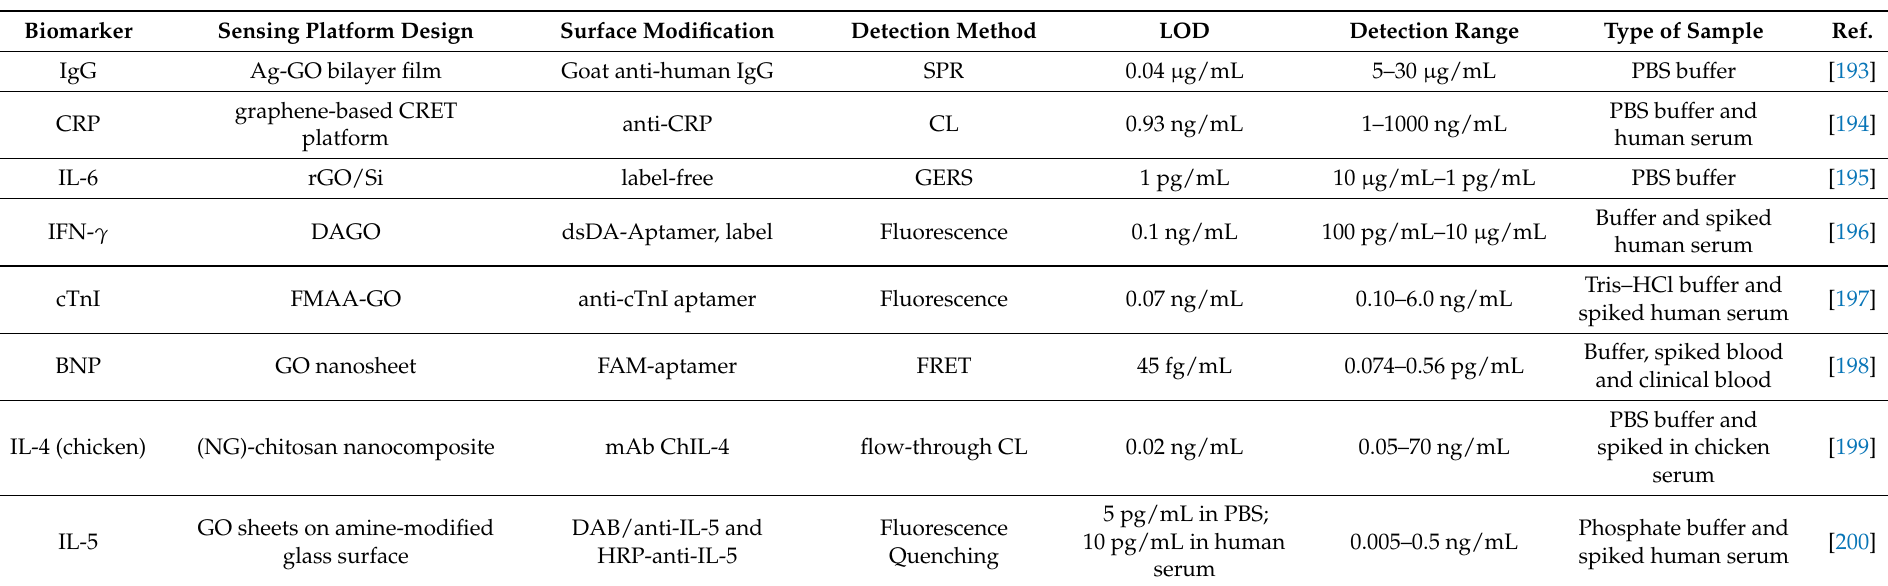
Table 3. Summary of optical biosensors assisted with GDMs for detection of inflammatory disease